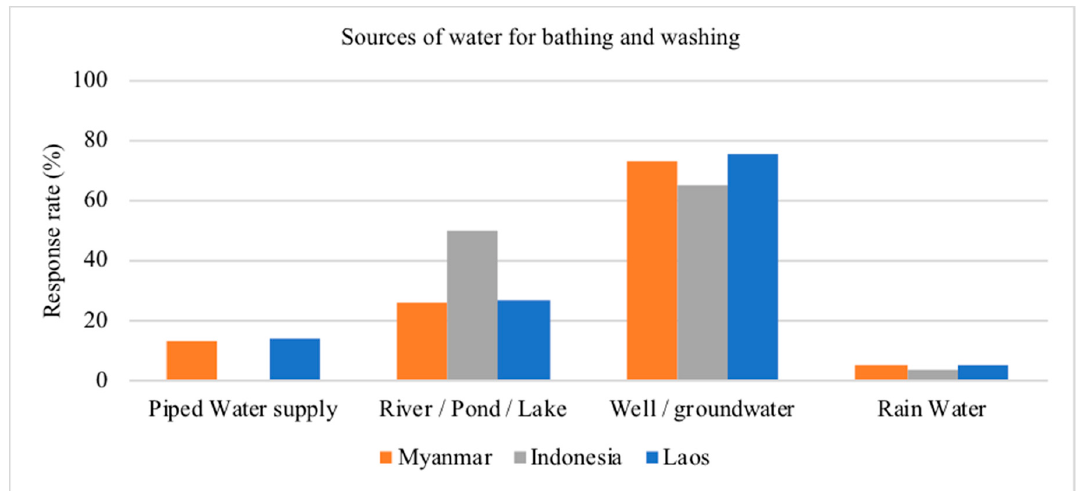
Figure 2. Sources of water for bathing and washing in the three case study villages